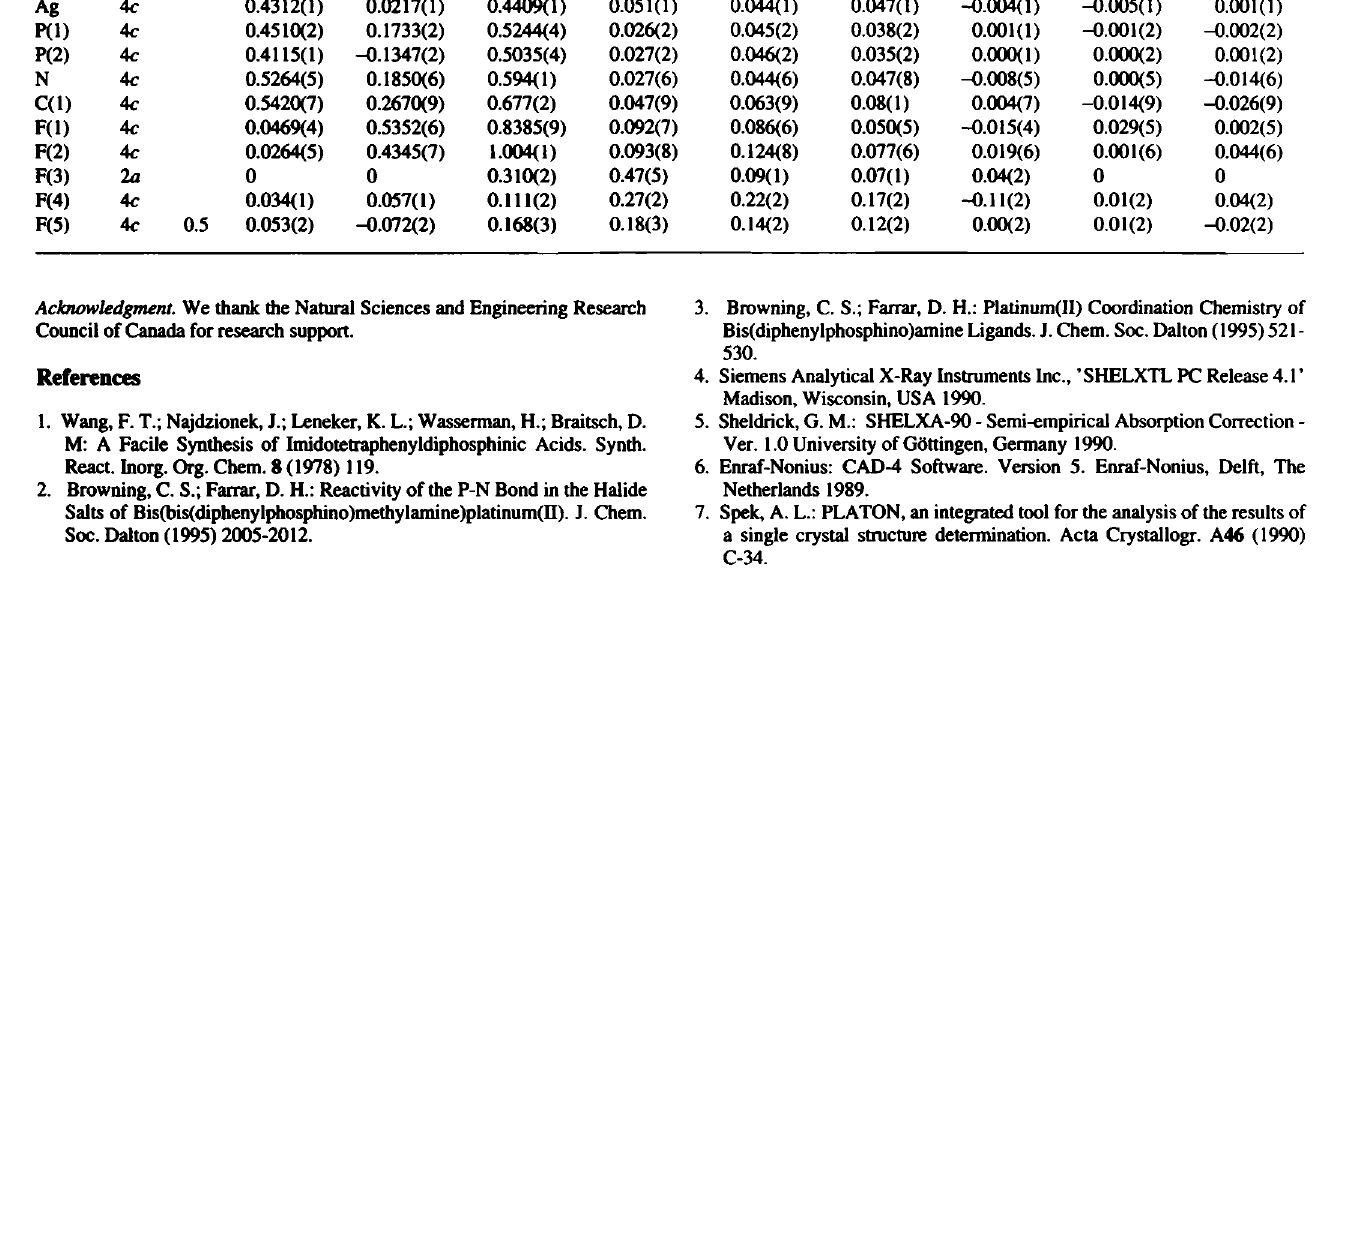
Table 3. Final atomic coordinates and displacement parameters (in Â 2 ) Atom Site